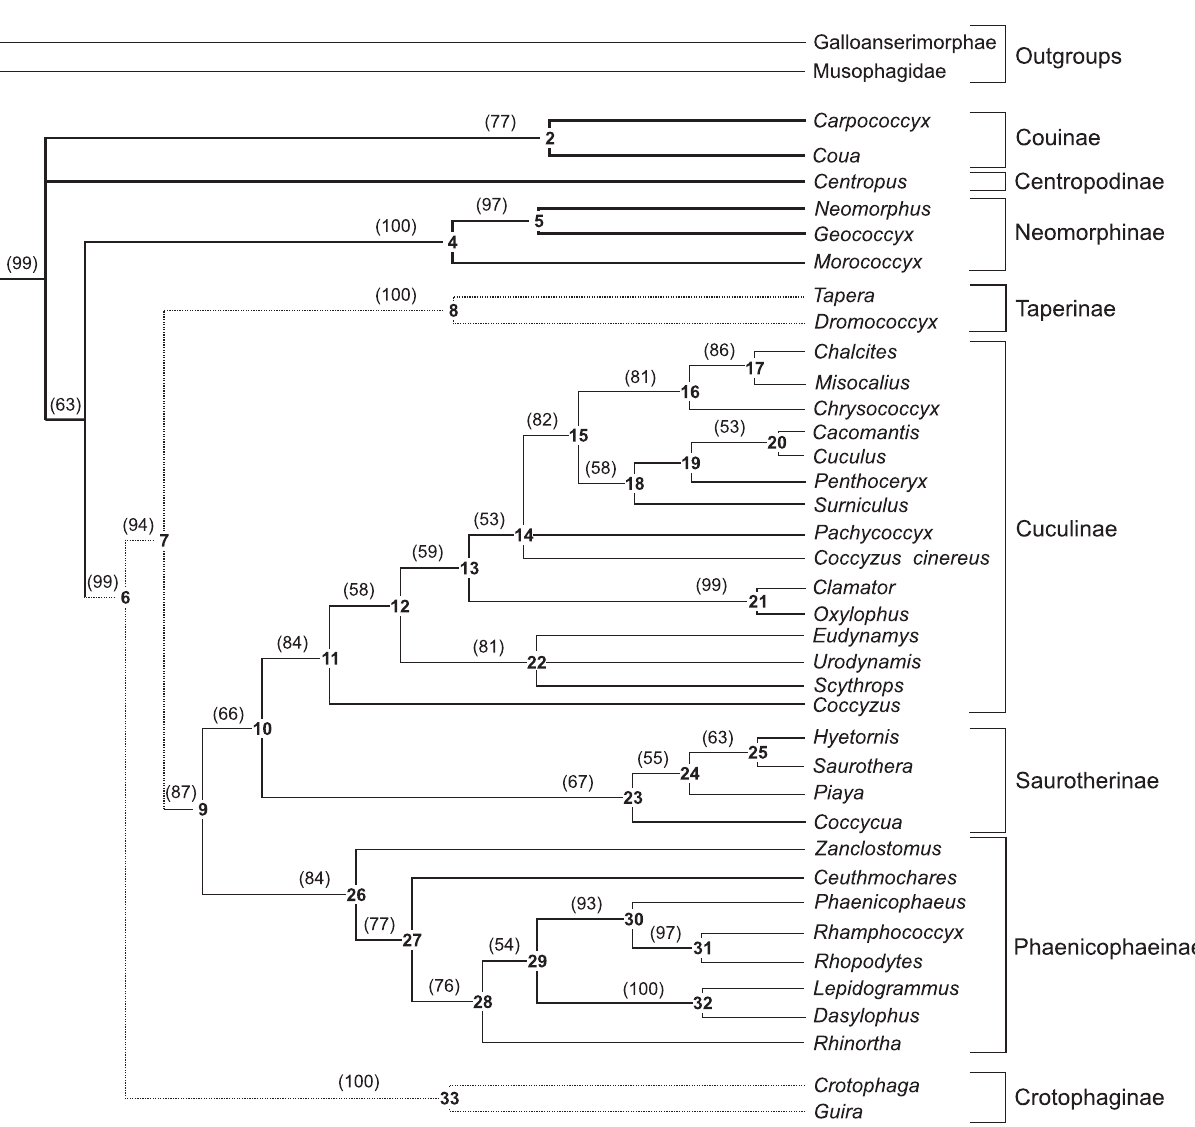
Figure. 1. Strict consensus cladogram (P OSSO & D ONATELLI 2006). 1-33: internodes; (51-100): percentages of Bootstrap analysis; spotted lines: terrestrial/arboreal habits; thick lines: terrestrial cuckoos; thin lines: arboreal